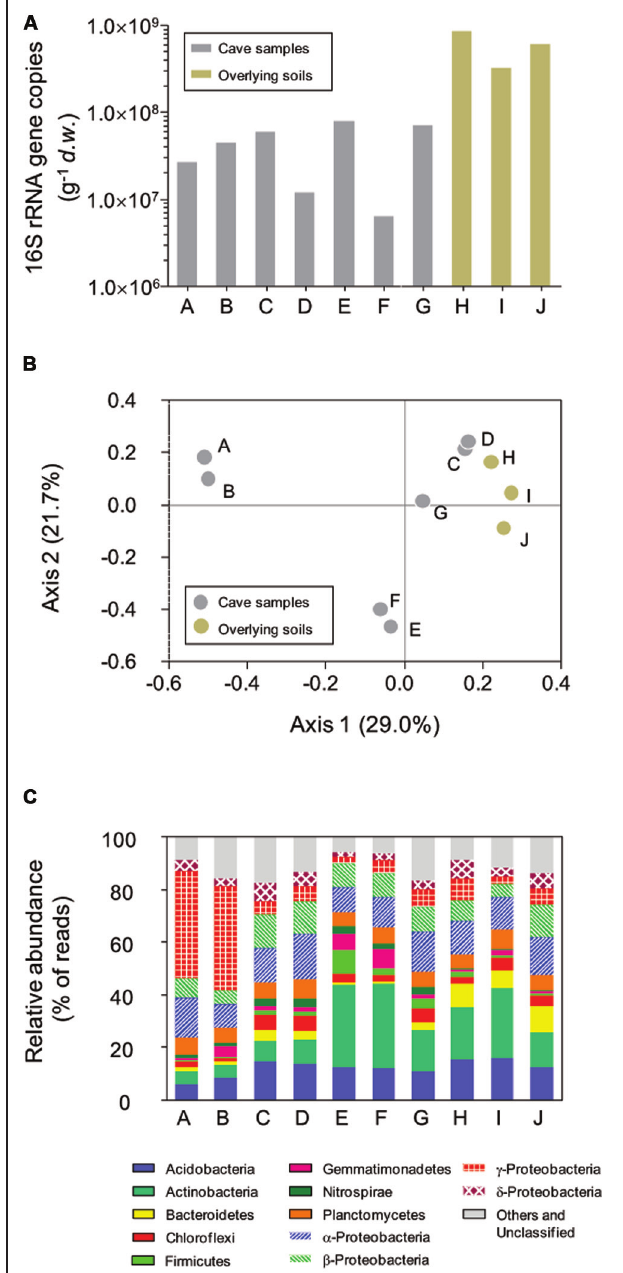
FIGURE 2 | Abundance of bacterial 16S rRNA genes (A), principal coordinate analysis (PCoA) plot based on Bray–Curtis distances (0.03 cutoff) between samples (B), and the relative abundance of dominant phyla in Jinjia Cave and related surface soils (C). Samples A, B, E, and F are from cave wall deposits, C and D are from pool sediments, G is a sinkhole soil and H–J are overlying soils.